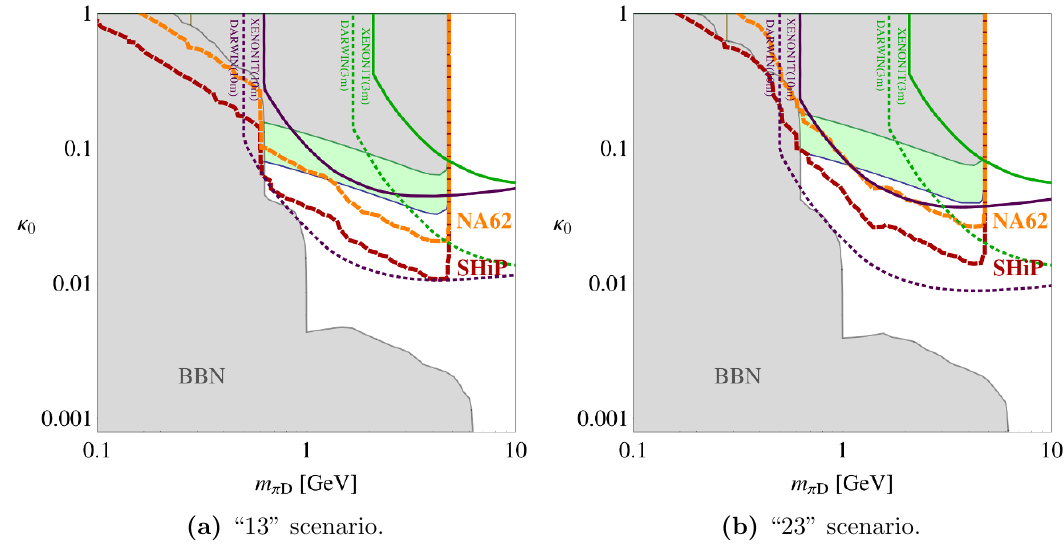
Figure 10. Within the dark red (orange) region, more than 3 dark pion decays are expected over the full run in SHiP (NA62 beam-dump mode). Overlaid are current (solid) and projected (dashed) dark matter direct detection bounds. The bounds in green are calculated under the assumption that the dark protons have a mass of 3 m (cid:25) , while in purple the dark protons are assumed to have D a mass of 10 m (cid:25) . The greyed regions are excluded by BBN or (cid:13)avour constraints. The light green D region is where upcoming measurements of Br( B K (cid:22) (cid:23)(cid:23) ) at Belle II is expected to have sensitivity. ! The parameter space in the left (right) plot corresponds to the \13" (\23") scenario, and taking M X = 1 TeV, f D = m (cid:25) D